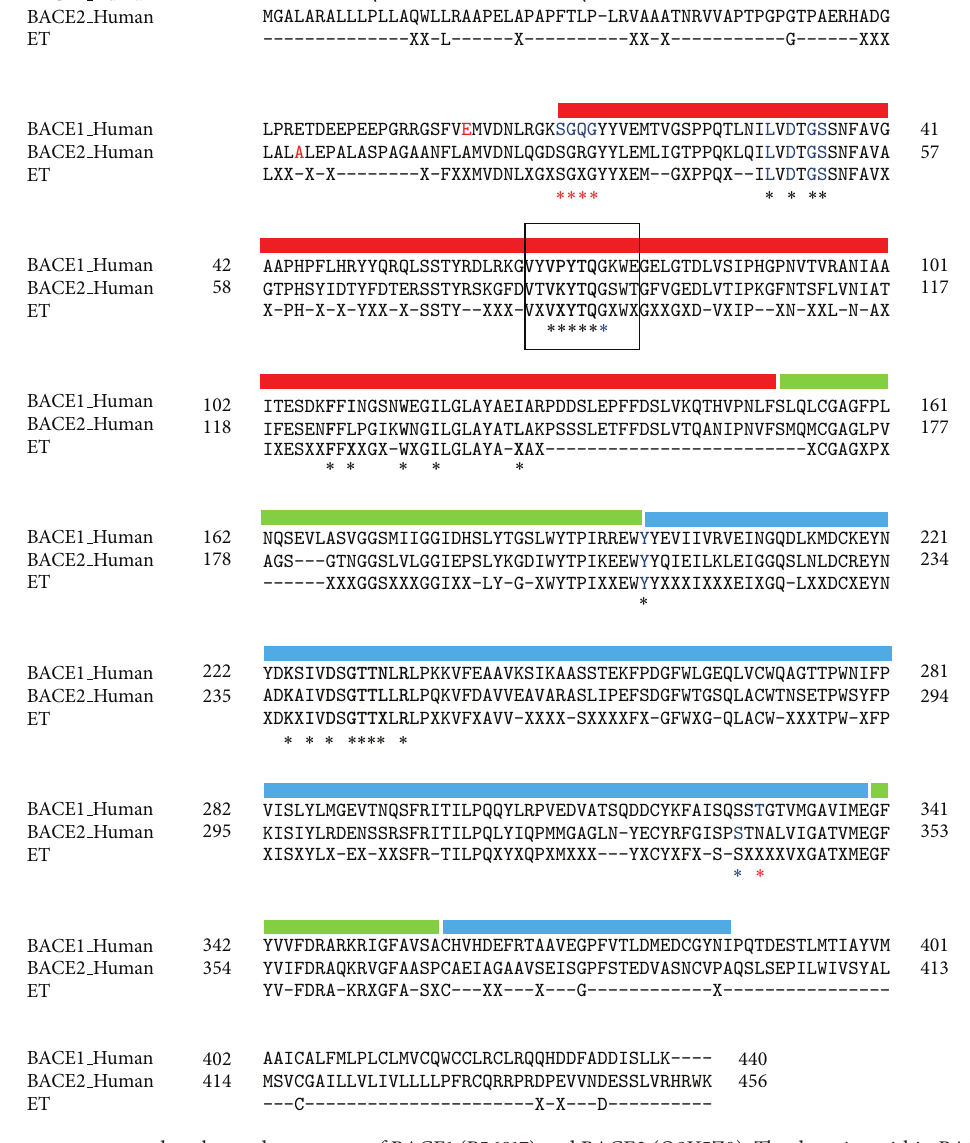
Figure 2: ET sequence compared to the seed sequences of BACE1 (P56817) and BACE2 (Q9Y5Z0). The domains within BACE1 and BACE2 sequences are marked with the coloured thick lines. Red and blue lines are for the N-terminal and C-terminal domains, respectively, whereas the green lines marked the interdomain regions within the structures. Amino acid residues for the flap region are marked within the box. Conserved residues are shown as their specific amino acid in the ET sequences, while group-specific residues are shown as alphabet “X.” Neutral residues are marked as “-” in the ET sequence. The amino acid numbering of BACE1 and BACE2 sequences is according to their 3D structures obtained from PDB file, 1FKN, and 2EWY, respectively. The starting amino acid residues are highlighted in red. Amino acid residues that are involved in the ligand binding sites of BACE1 and BACE2 are marked with asterisk. Red coloured asterisks are binding sites that are only for BACE1, while blue coloured asterisks are the ligand binding sites that are only for